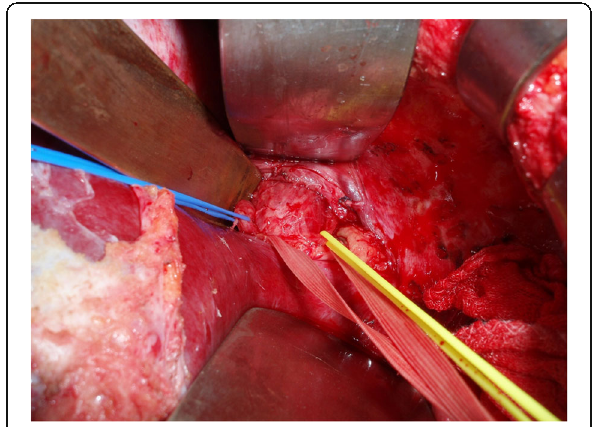
Fig. 3 The abdominal esophagus and esophagogastric